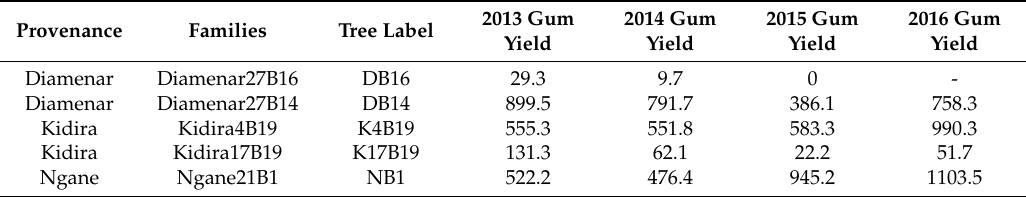
Table 1. Families and mean annual gum yields (g) by tree of the mother trees from which seeds in this study were harvested. (-) indicates that the tree